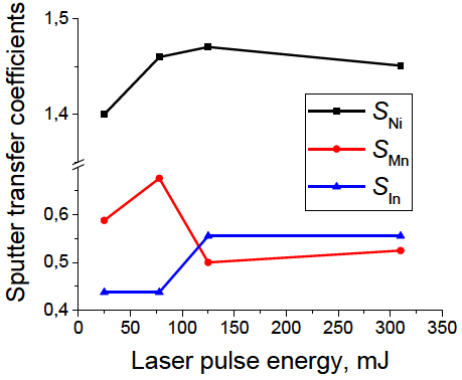
Figure 2: The dependence of the sputter transfer coeflcient S on laser pulse energy for the series of Ni-Mn-In